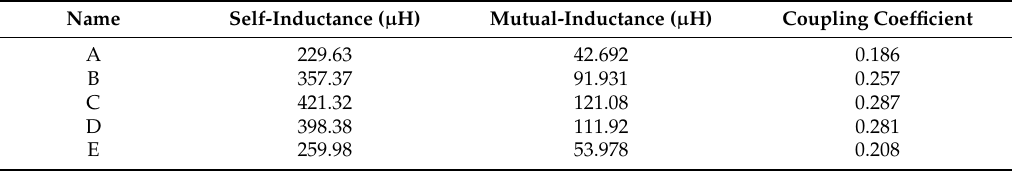
Table 1. Self-inductance, mutual-inductance, and coupling coefficient of five different coils.